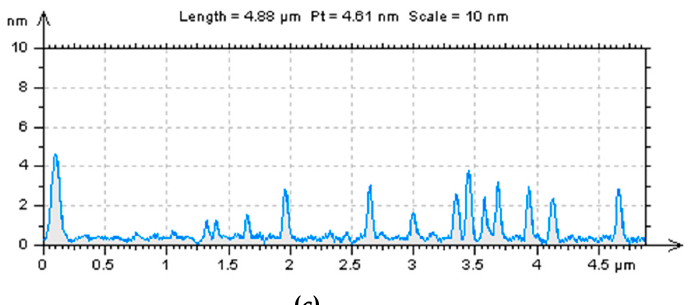
Figure 1. Morphological characterizations of “B-doped” C-dots: ( a ) TEM image of C-dots, the left inset is the enlarged image of one particle and the right inset is the size distribution histogram of C-dots; ( b ) atomic force microscopy (AFM) image of C-dots; ( c ) height profile of C-dots corresponding the profile line in Figure 1b.